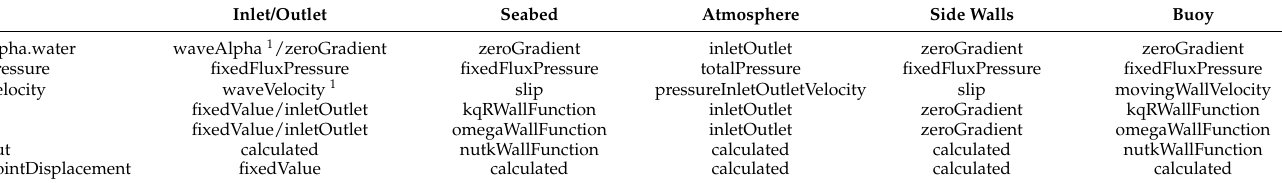
Table 3. CFD boundary conditions.